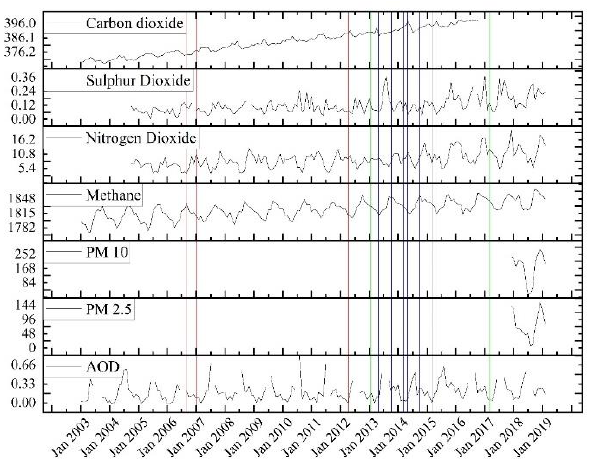
Fig 1: Trend of trace gases under observation. The straight lines in the figure mark the installation of new thermal power plant. The Red lines label for NTPC, Green for Essar, Blue for Reliance and Orange for Hindalco.